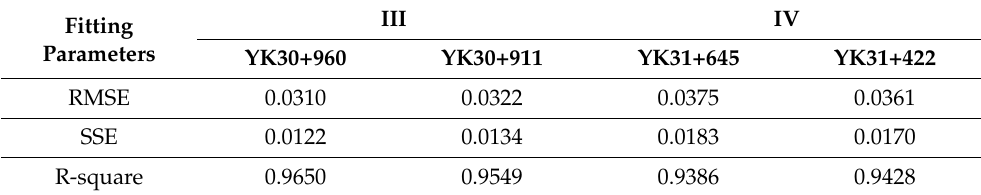
Table 3. Fitting parameters of surrounding